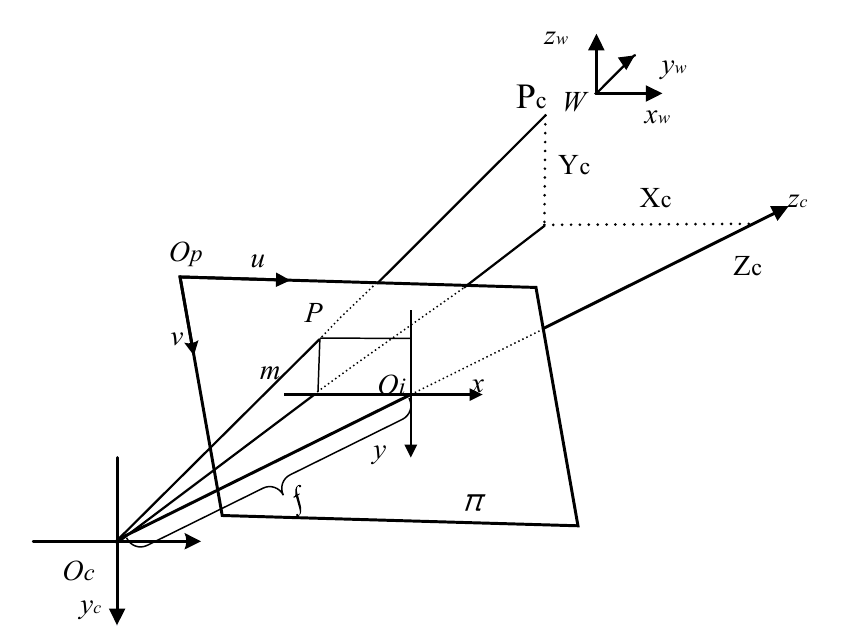
Figure 2. Small-hole imaging and projection imaging model. The point coordinates of a point in space in the world coordinate system are ( x w , y w , z w ) , corresponding to the coordinates on the pixel plane O p − uv . The transformation can be expressed